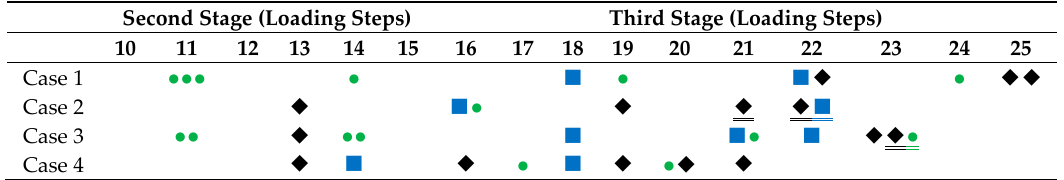
Table 7. Cracks distribution in each loading